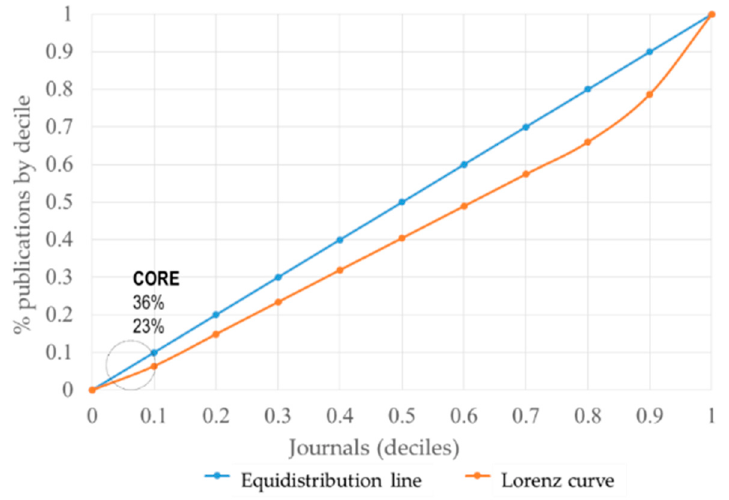
Figure 3. Lorenz curve-Bradford core of the most productive journals. Source: own elaboration.